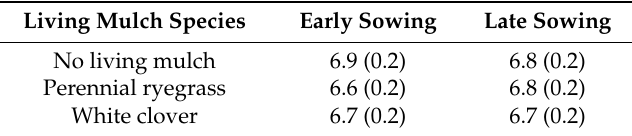
Table 5. Average grain yield ( t ha − 1 ) and standard error in parenthesis averaged over the fixed factors living mulch species and time of living mulch sowing in all seven experiments; interactions between living mulch species and sowing date and both factors were not significantly different from each other.